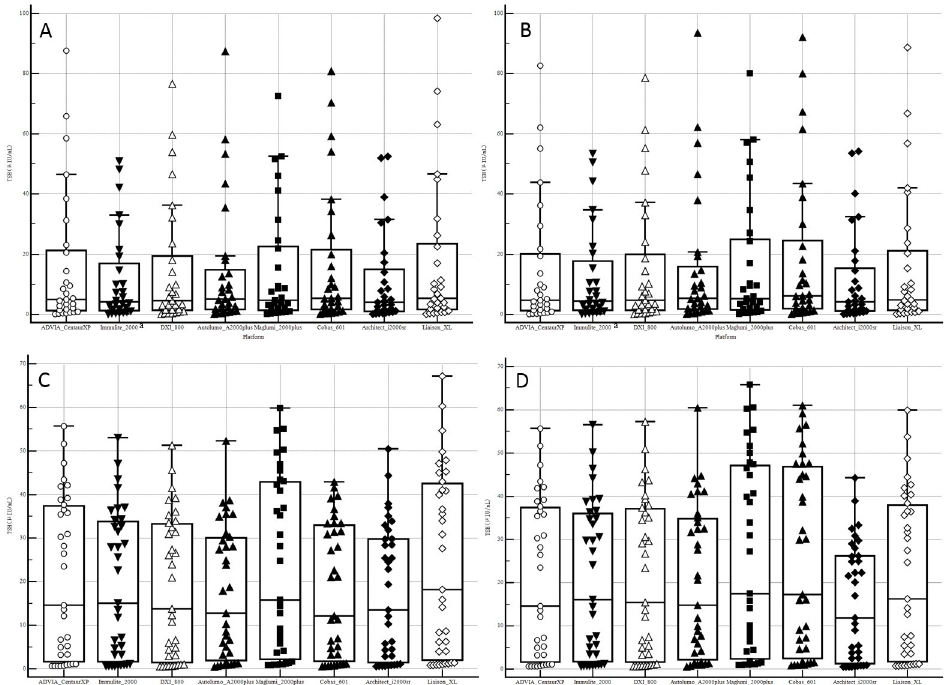
Fig 2. Boxplot showing the distribution of thyroid-stimulating hormone (TSH) measurement results for the eight assessed immunoassays. A and B, Results before and after systematic bias correction using individual human serum samples, respectively. C and D, Results before and after commutability-related bias correction using NCCL EQA samples, respectively. a, Results for one sample were excluded from analysis, as these were outside the analytical measurement